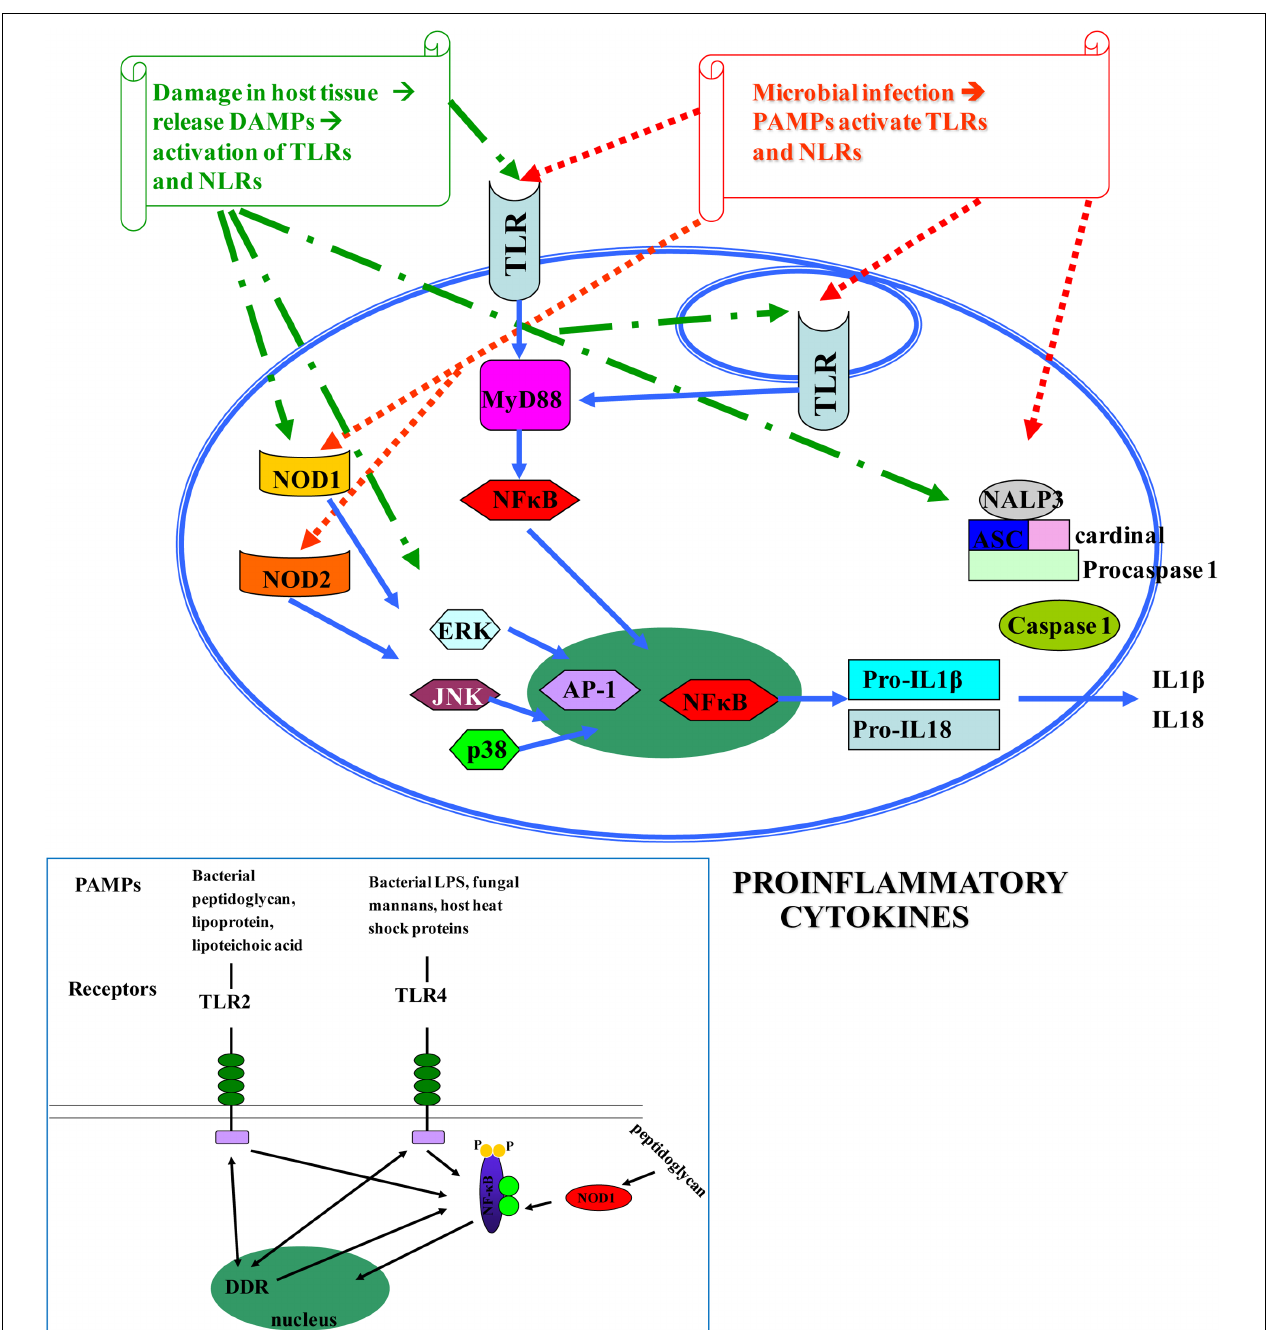
FIGURE 1 | Pathogen-associated molecular patterns (PAMPs) [microbial nucleic acids, including DNA (e.g., unmethylated CpG motifs), double-stranded RNA (dsRNA), single-stranded RNA (ssRNA), 5 (cid:48) -triphosphate RNA, lipoproteins, surface glycoproteins, and membrane components such as peptidoglycans, lipoteichoic acid, lipopolysaccharide (LPS), and glycosylphosphatidylinositol] and DAMPs [endogenous molecules normally found in cells and released during cell death, such as ATP, uric acid, the cytokine IL1a, heparin sulfate, RNA, and DNA] (Kawai and Akira, 2010; Tang et al., 2012) bind to TLRs and NLRs, activate NF- κ B and AP-1 transcription factors and lead to the production of pro-inflammatory cytokines that perpetuate inflammation and induce tissue damage. DAMPs are localized within the nucleus and cytoplasm (HMGB1), cytoplasm alone (S100 proteins), exosomes (heat shock proteins, HSP), the extracellular matrix (hyaluronic acid), and in plasma components such as complement (C3a, C4a, and C5a), but also, they can be mimicked by release of intracellular mitochondria, consisting of formyl peptides and mitochondrial DNA (with CpG DNA repeats) (Tang et al., 2012). Different TLRs serve as receptors for diverse ligands (Mitchell et al.,